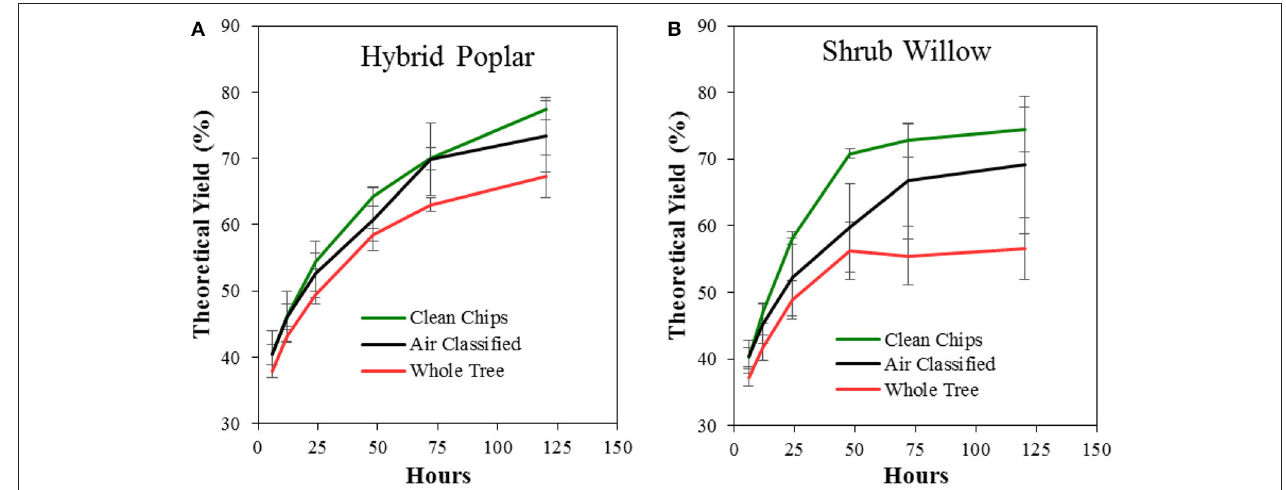
FIGURE 1 | Biochemical conversion of whole and fractionated (A) hybrid poplar and (B) shrub